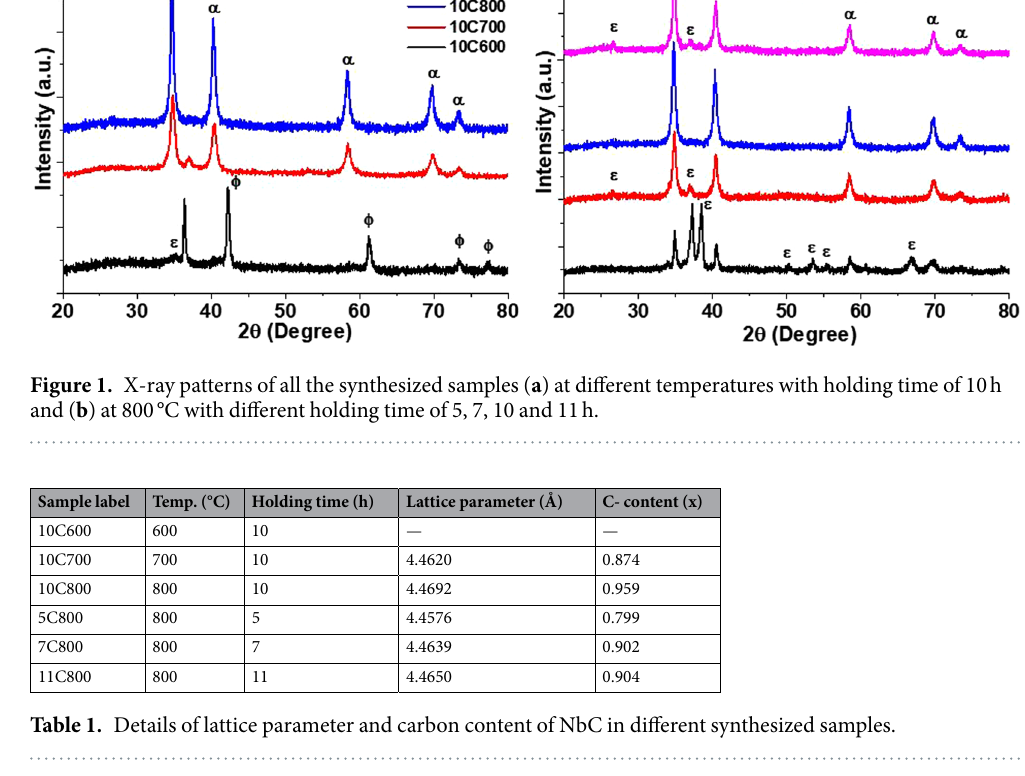
Table 1. Details of lattice parameter and carbon content of NbC in different synthesized